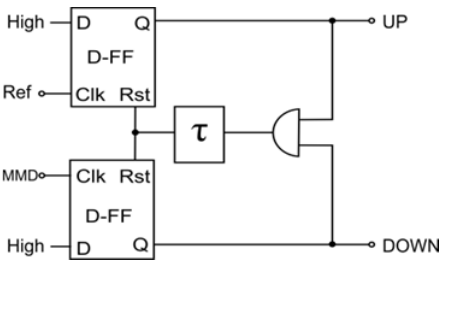
Figure 5. Schematic of the Phase-Frequency